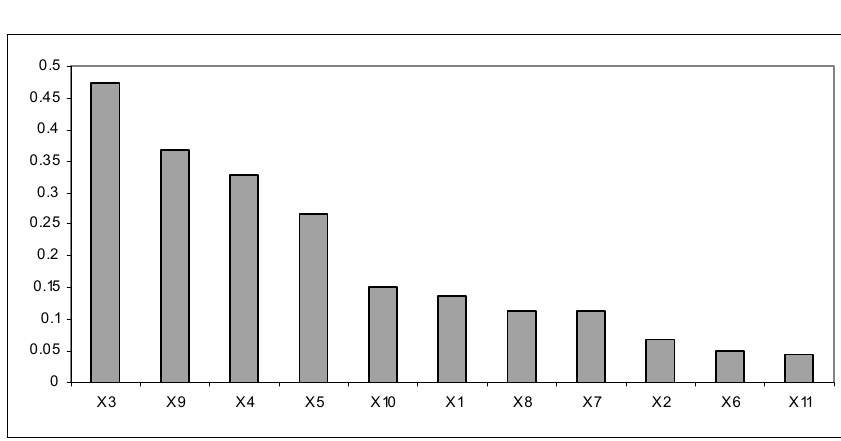
Figure 1 – Poverty ratios by attribute, mean over the 7 surveys